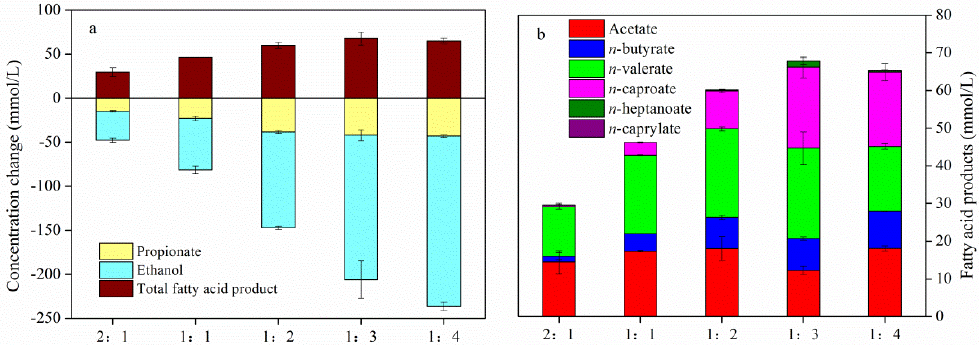
Figure 4. Substrate consumption (negative values) and product formation (positive values) ( a ) and fatty acid product distribution ( b ) with propionate as the electron acceptor under the maximum reaction degree.